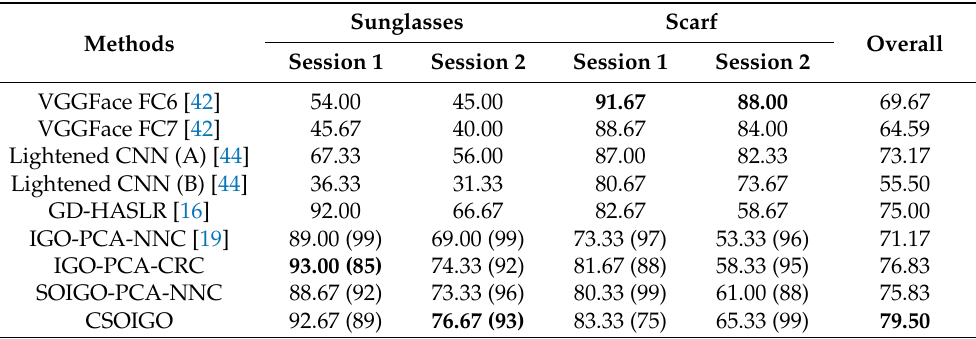
Table 3. Comparison with CNN-based approaches on a subset of the AR database (test samples contain sunglasses occlusion or scarf occlusion) when only one neutral face image per subject from Session 1 is used as training samples. The dimension that leads to the best result for IGO- and SOIGO-based approaches is given in parentheses.